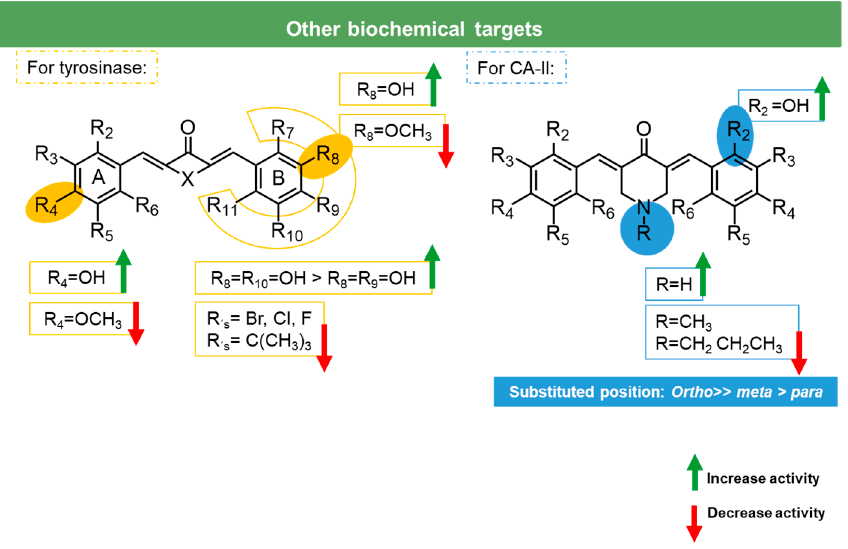
Figure 19. Putative SAR diarylpentanoids described for their ability to interfere with several proteins.